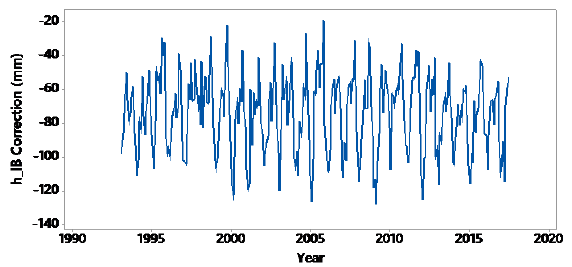
Fig. 2. IB correction at Key West TG station.